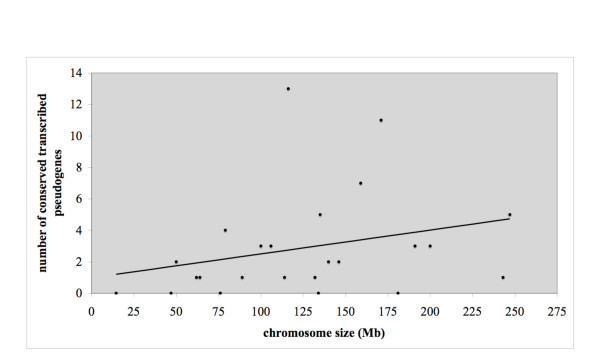
A scatter plot showing the number of conserved TPAs on each human chromosome versus the chromosome size (in Mb). The chromosome X is circled. The collective size of the human genome, excluding chromosome X, is 3,098,124,053; and the size of the chromosome X after normalizing for chromosome dosage in gametes, as done by Emerson et al. [30], is 116,185,316 (i.e., 0.75 times the original size of 154,913,754), which harbors 13 transcribed preserved pseudogenes. Since the collective genome size is 27 times bigger than that of the human chromosome X, we expect 2 or 3 preserved pseudogenes on the chromosome X. Presence of 13 cases, an increase of more than 4.5 times than expected, suggests a statistically significant overrepresentation (exact binomial test of goodness-of-fit, P-value < 10-5, for the null hypothesis (H0) that there is no difference between the observed and expected frequencies of transcribed preserved pseudogenes on the chromosome X).